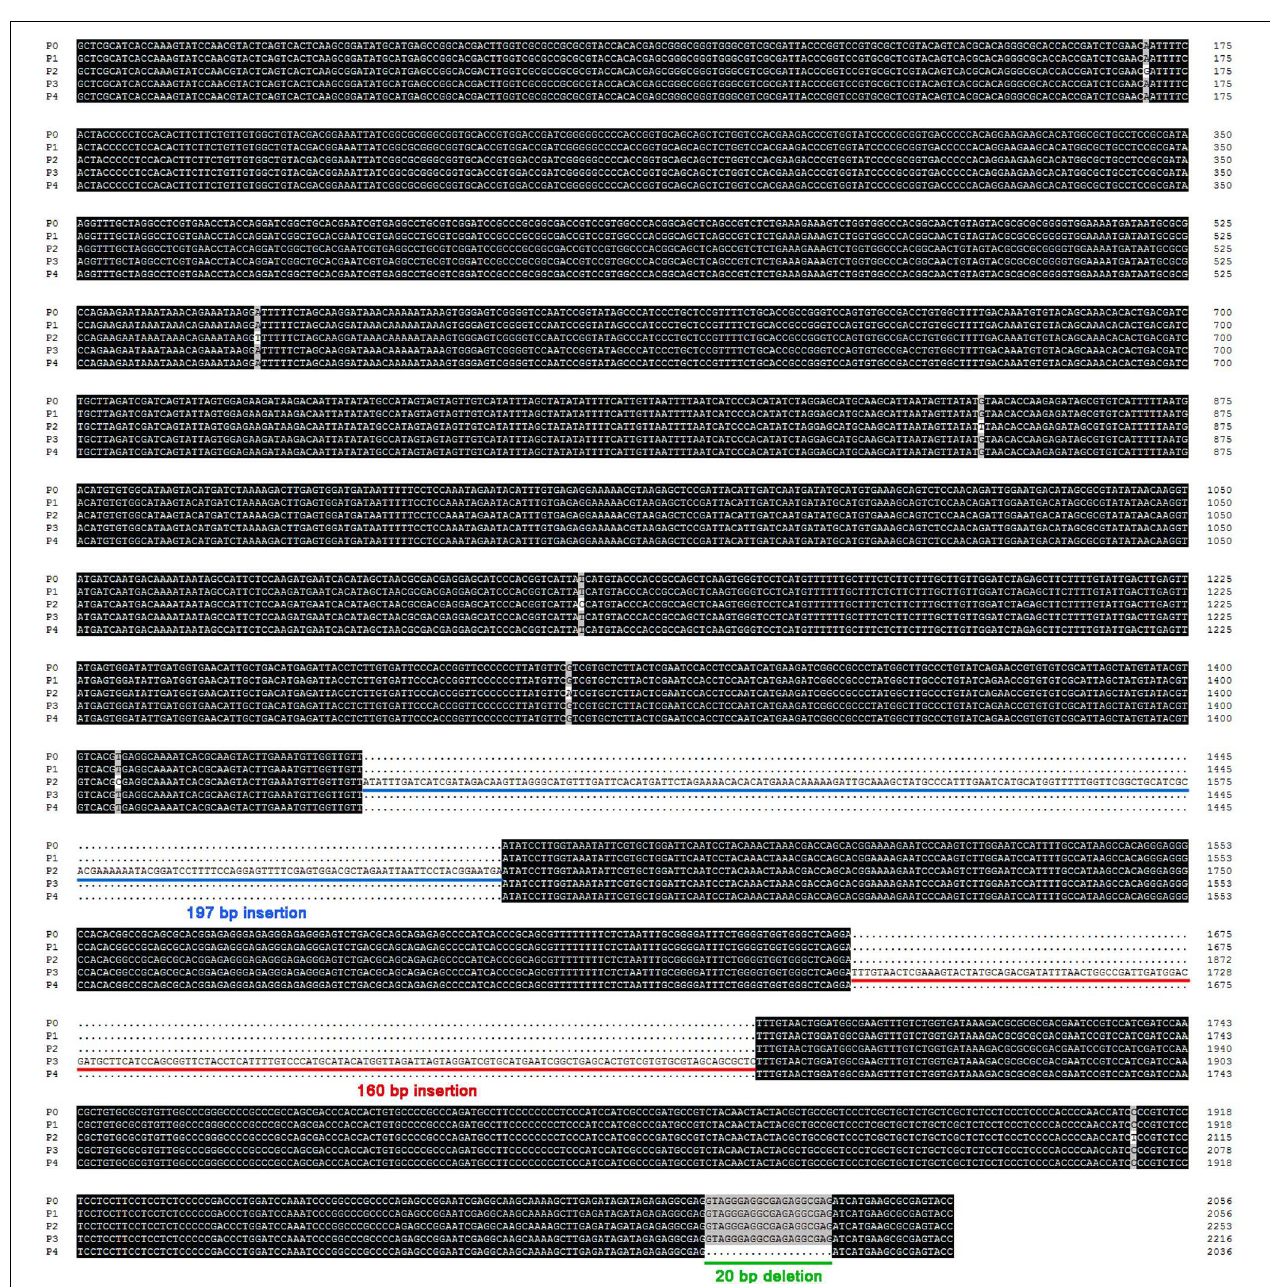
FIGURE 2 | Sequence alignment for promoters of Rht-B1 allelic variations in wheat. Four promoters cloned from seventy wheat lines containing different allelic variations at the Rht-B1 loci. Compared with the promoter of Rht-B1a (P0), P1 was coincide exactly with it, P2 had a 197 bp insertion (sequences on blue lines), P3 had a 160 bp insertion (sequences on red lines), and P4 had a 20 bp deletion (sequences on green